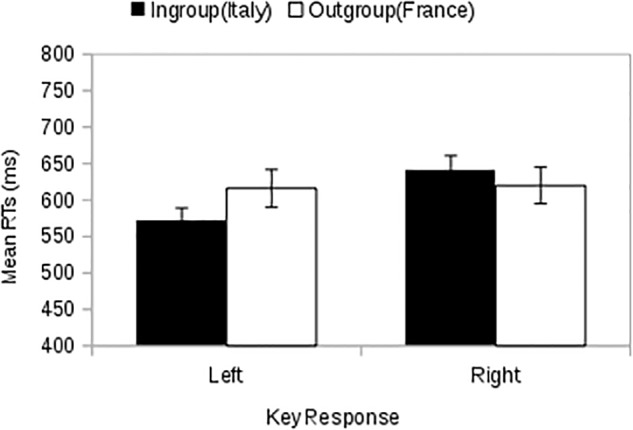
Study 2: The Spatial Organization of Social Categorization effect when the social categories are represented by Nationalities (Italy = Ingroup vs. France = Outgroup). Error bars indicate ±1 MSE.